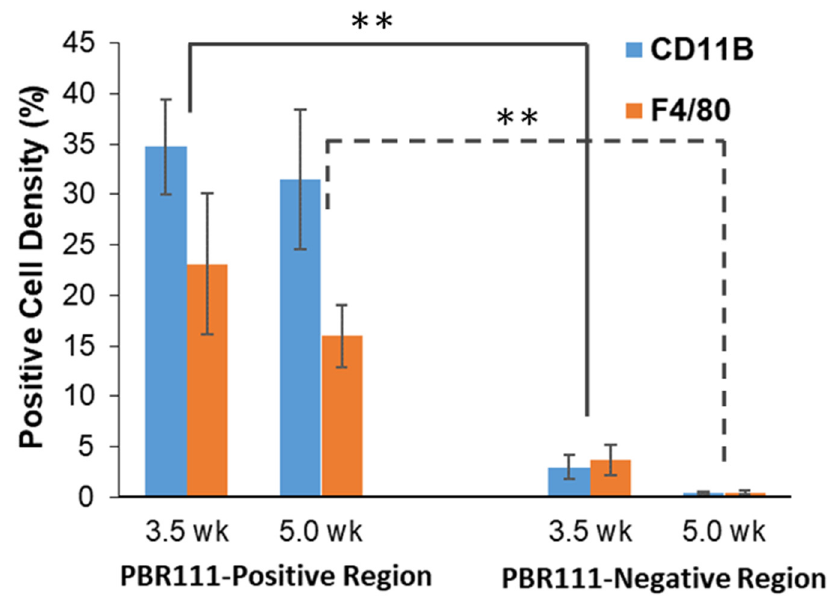
Figure 7. Cell density graph of positively stained CD11b and F4/80 in regions defined as 18